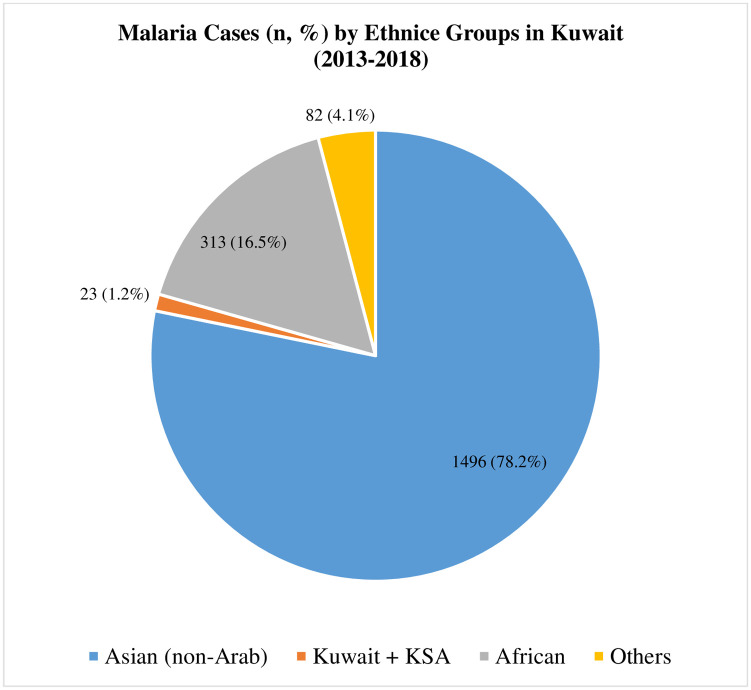
A pie chart showing the share (n, %) of reported malaria cases among the ethnic groups in Kuwait (2013–2018).